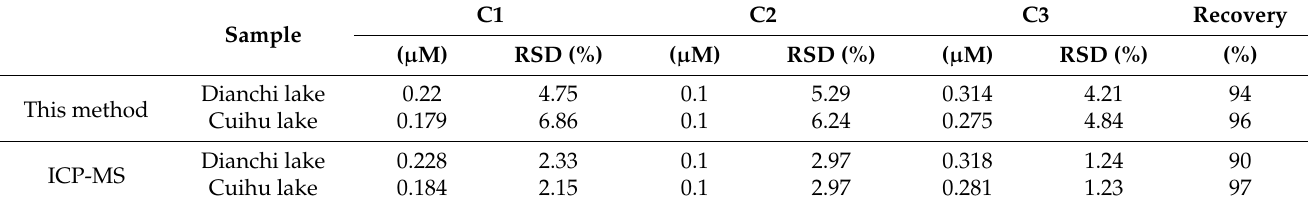
Table 2. Determination of Cu 2+ in four different water samples using the biosensor and ICP-MS.